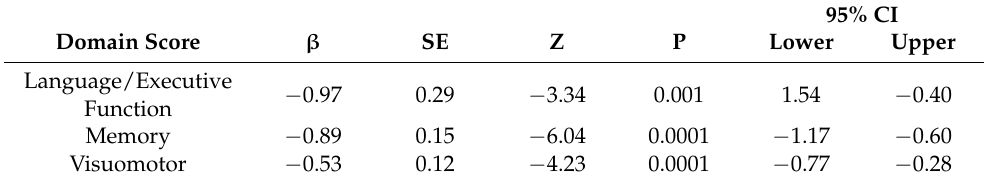
Table 4. Path model comparing CS to MCI-DS adjusted for sex and premorbid ID level ( n = 144).